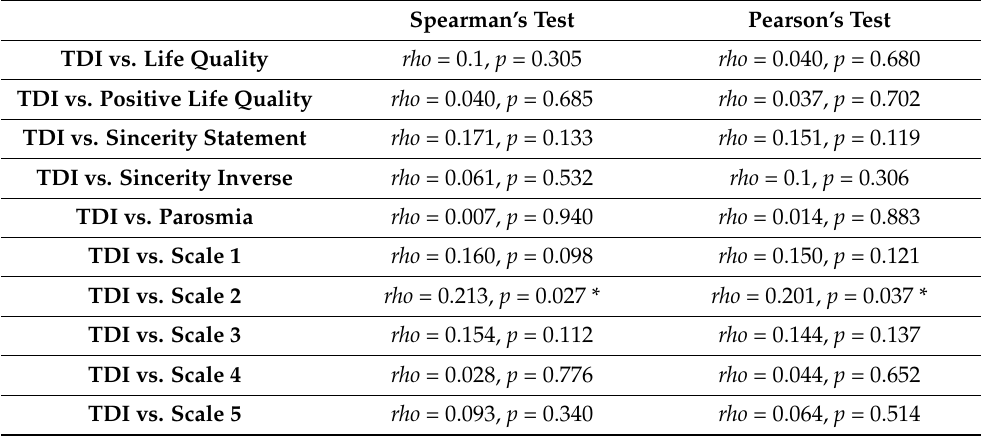
Table 3. Correlation analyses between the TDI and QOD results. Spearman’s and Pearson’s correla- tion tests were used to detect a nonlinear and linear correlation, respectively. A statistically significant correlation was defined with a p -value < 0.05 *. A perfect correlation can be indicated by a rho of 1. The * indicates a statistically significant correlation. QOD = questionnaire of olfactory disorders; TDI = Threshold, Discrimination, Identification. Spearman’s Test Pearson’s